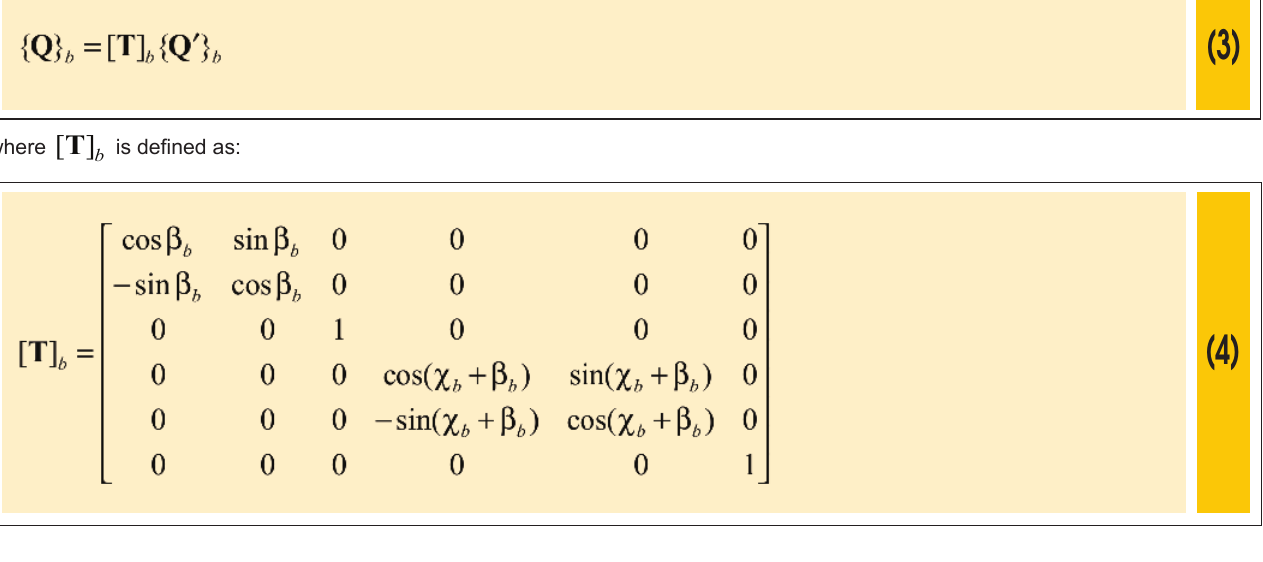
Figure 2.1 – Internal forces in local coordinates and generalised